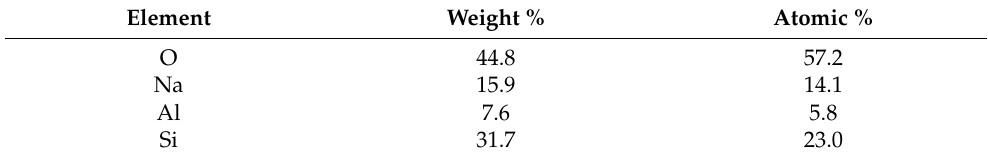
Table 10. The chemical components detected on the surface of LWA impregnated with NaOH.